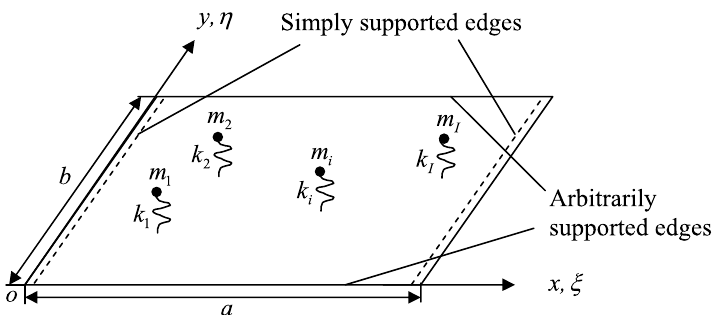
Fig. 1. A rectangular plate having two opposite edges simply supported and other two opposite edges arbitrarily supported, with discrete sprung masses